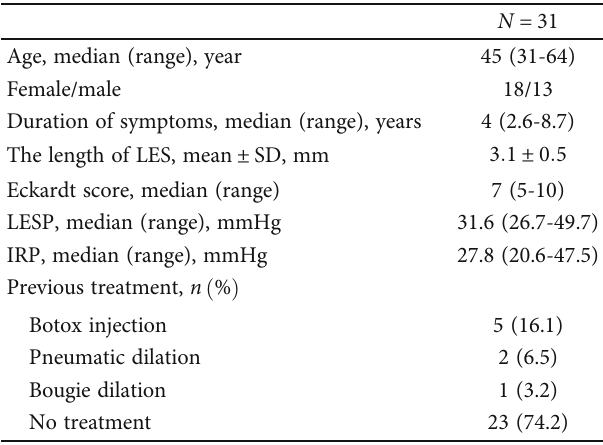
Table 1: Patient characteristics.